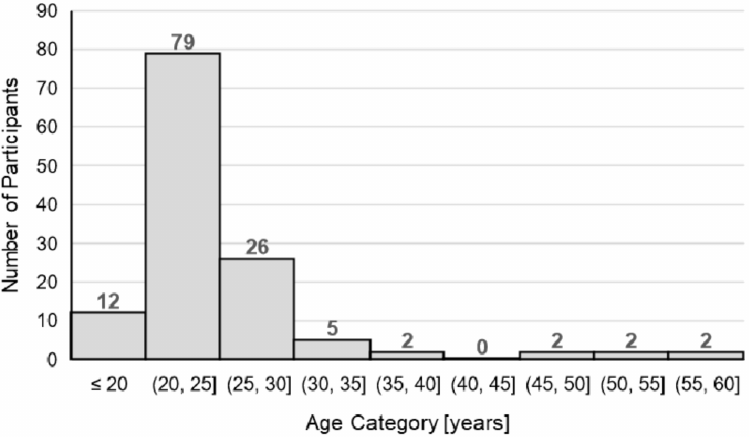
Figure 4. Histogram of the age